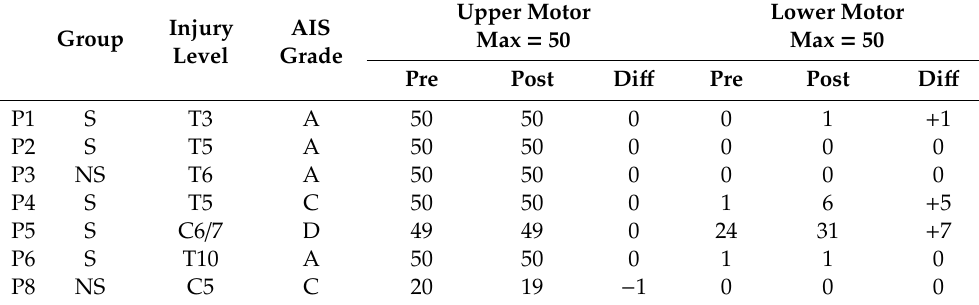
Table 3. International Standard for Neurological Classification of Spinal Cord Injury (ISNCSCI) before (pre) and after (post) the intervention for participants in transcutaneous spinal cord stimulation (tSCS) combined with sit-to-stand training (STIM (S)) and sit-to-stand training alone (NON-STIM (NS)) groups. Upper Motor Injury AIS Group Max = 50 Level Grade